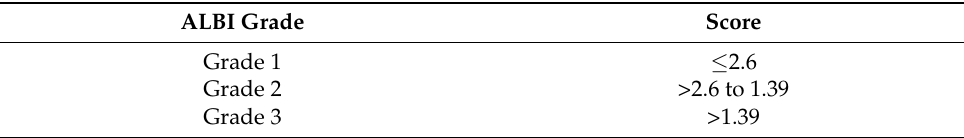
Table 4. Albumin–bilirubin (ALBI) score.